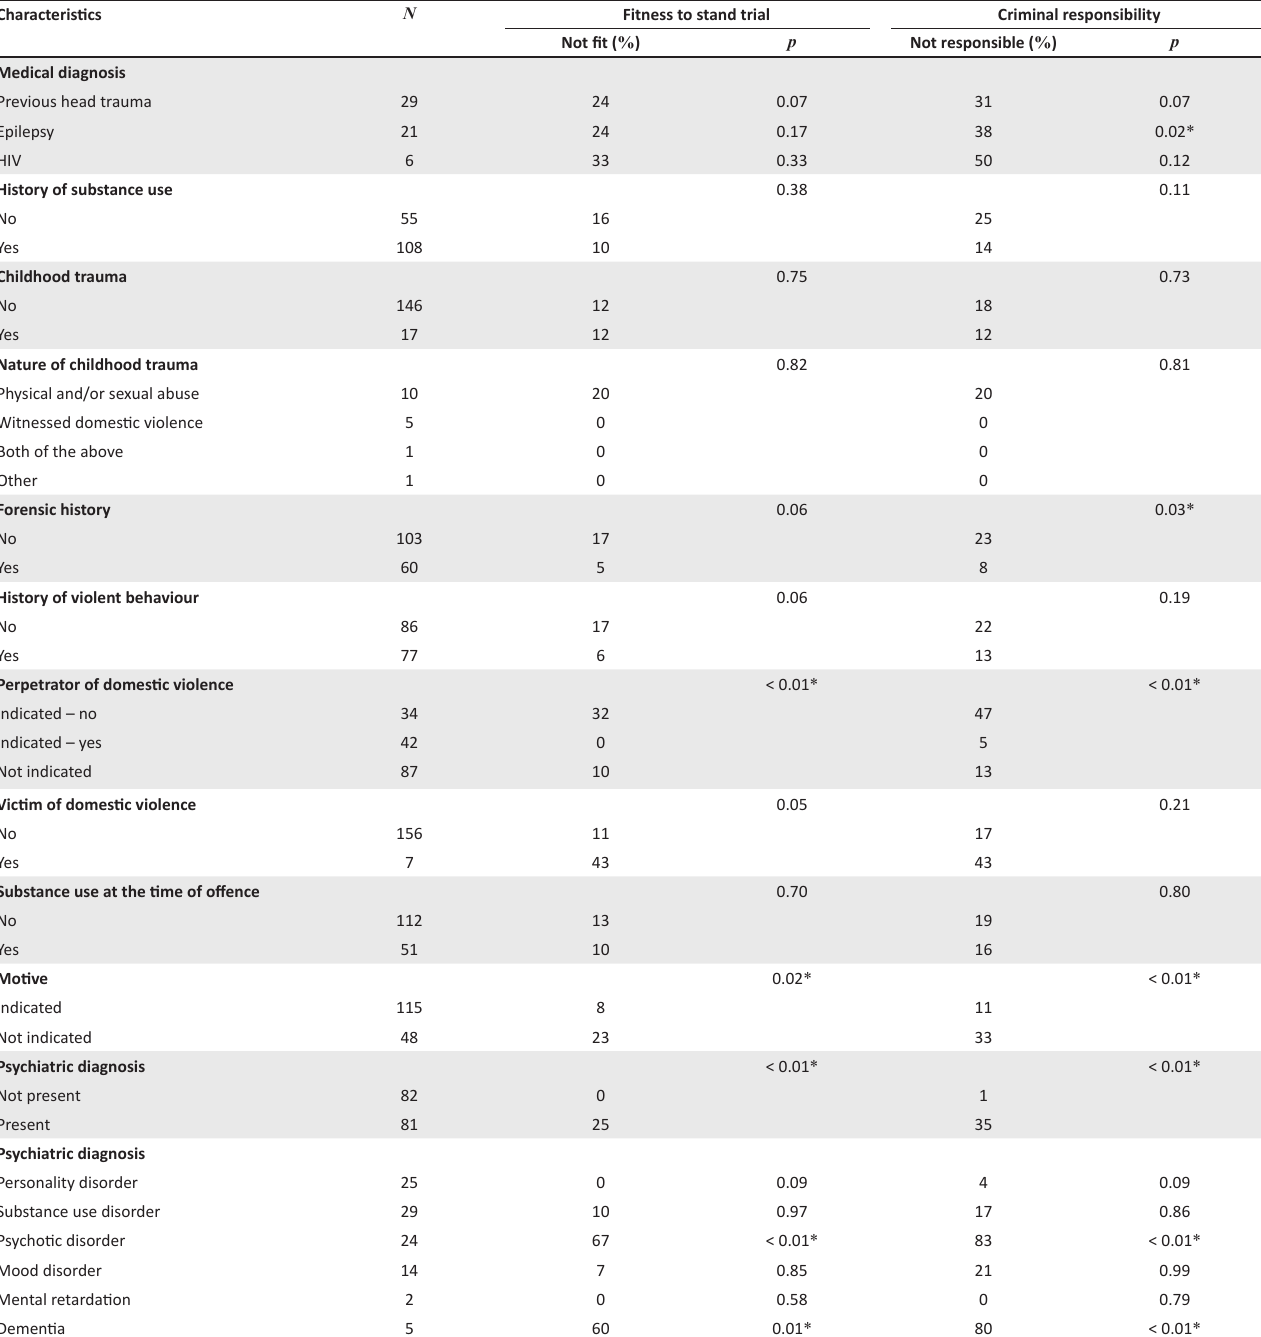
TABLE 4 (Continues...): Accused and offence characteristics and diagnosis according to the categories of psychiatric observation outcomes with p values.